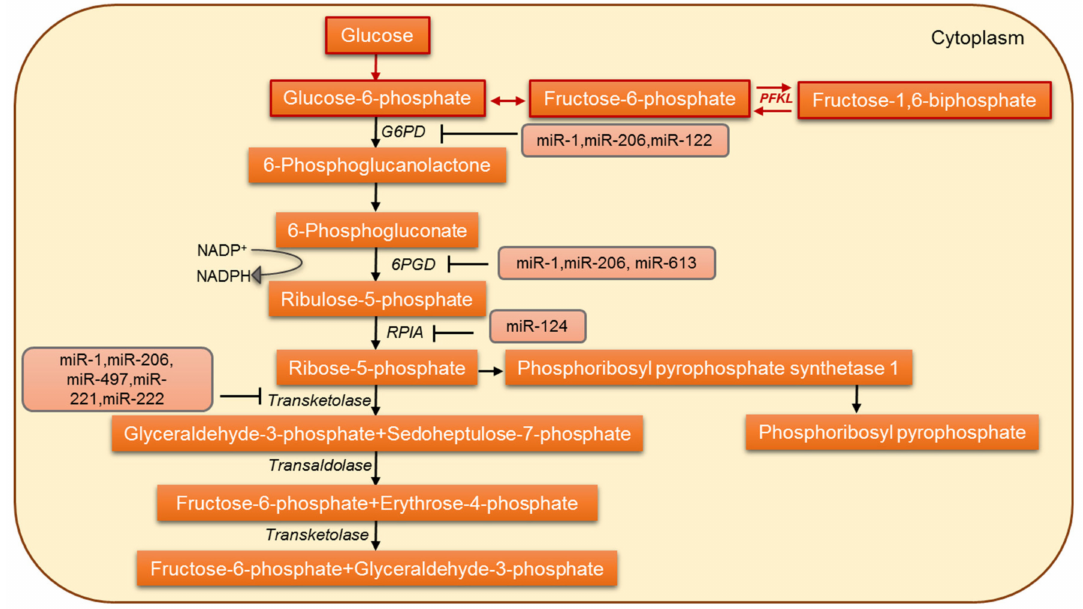
Figure 3. The miRNA-based regulation of the pentose-phosphate pathway in cancer